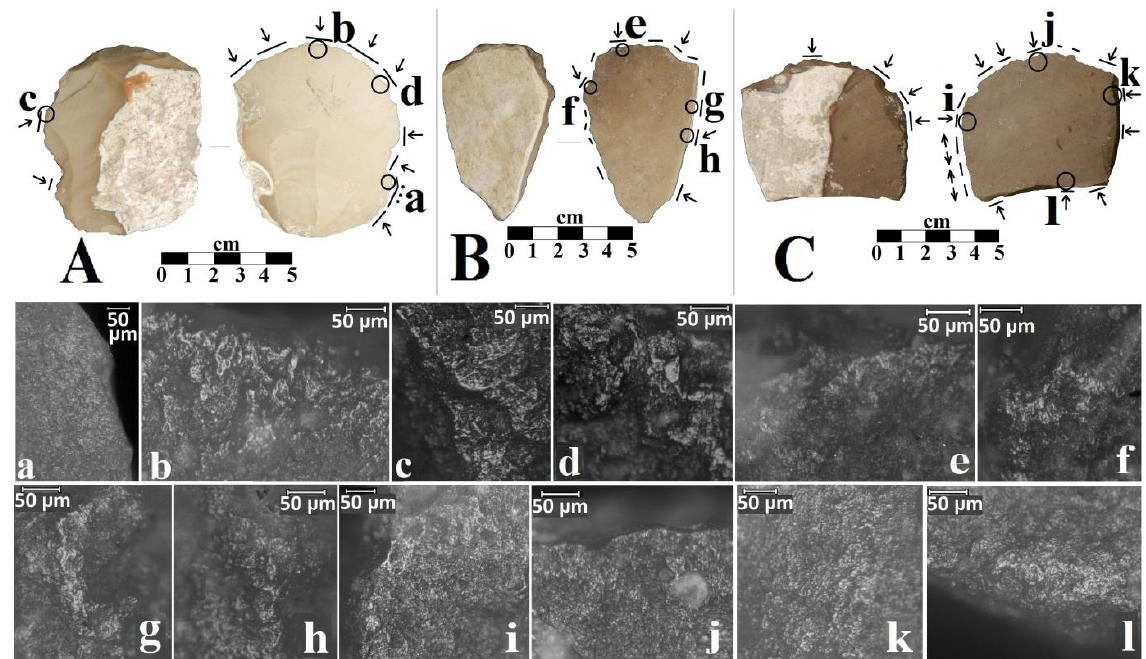
Figure 2. Fan scraper with prehension traces ( A, a ) and scrapers with steep edge-angles used to smooth bone and also to scrape bone to remove meat or periosteum ( A, B, C) . Bright bone and rough meat polish shown on b-j , and l . Fresh hide or meat wear traces in from edges ( k ) are on C not well-developed. Fan scrapers were held in the hand and used for butchering and scraping meat off bones. Photomicrographs are 187.5x, scales are 50 microns. A. Dorsal (left) and ventral (right) faces of oval cortical fan scraper (CFS, MW#5) from Area B, late Pottery Neolithic (PN) level, Locus 3538, Bucket15055. B . Triangular CFS fan scraper fragment (MW#10) from Area C, late PN level, Locus 1976, Bucket17805. C : Flat FCFS fan scraper fragment with geometric incisions on cortex (MW#19) from Area E, late PN level, Locus 3135, Bucket30750. White lines show extent of the usewear, line with dots: location of prehension traces, arrows show orientations of microwear polishes and striations, circles: locations of microphotographs a-l